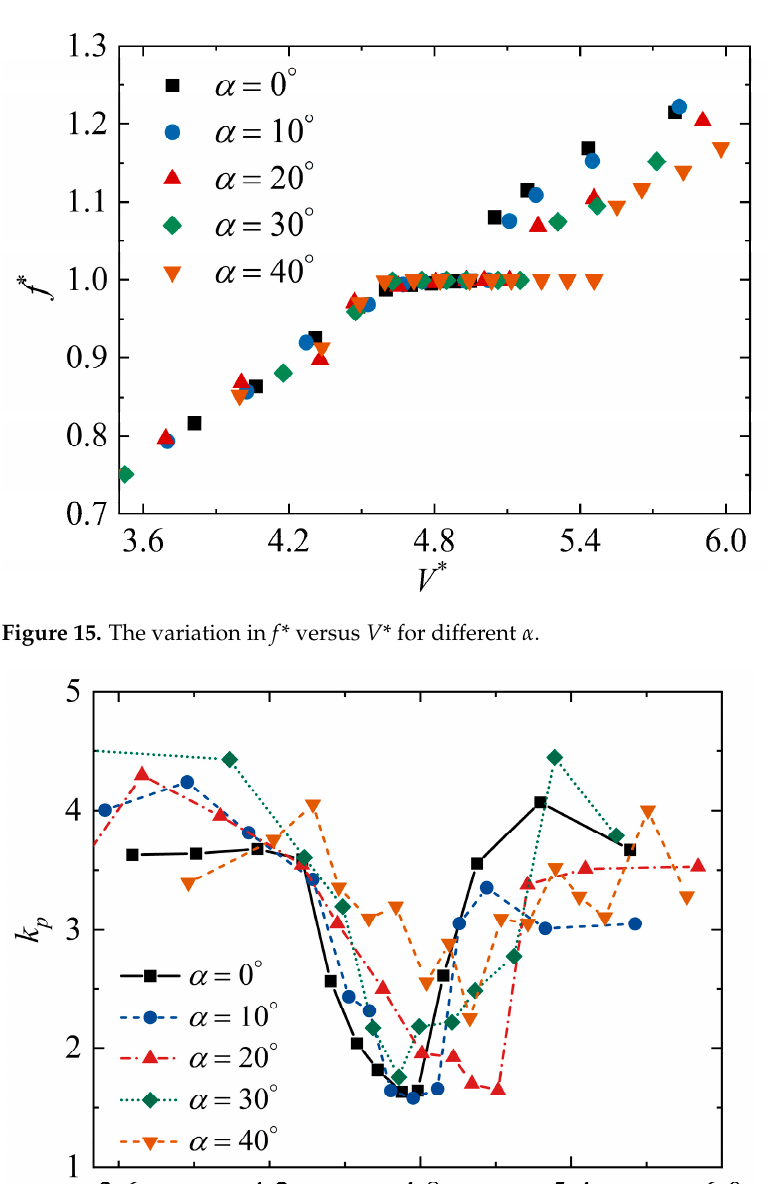
Figure 14. The variation in A* versus V* for different α .